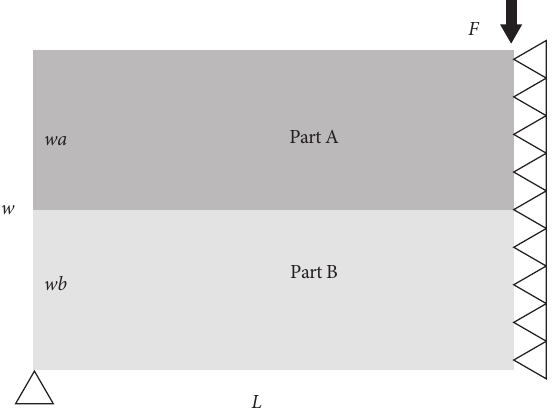
Figure 1: Two-dimensional bimaterial model of three-point bending established in FEM simulation.